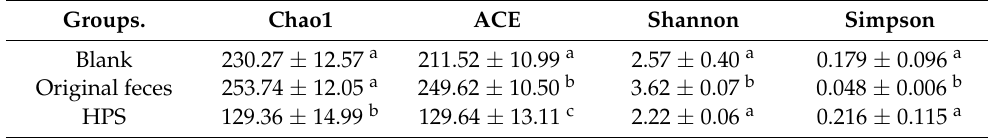
Table 4. Effects of HPS on Alpha diversity of human gut microbiota. Groups. Chao1 ACE Shannon Simpson Blank 230.27 ± 12.57 a 211.52 ± 10.99 a 2.57 ± 0.40 a Original feces 253.74 ± 12.05